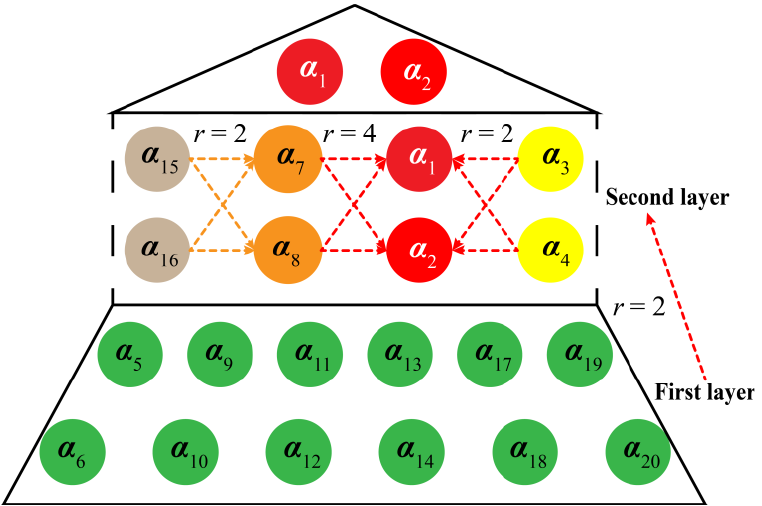
Figure 10. The polynomial functional relationship between active modal coefficients where r repre- sents the order of the library Θ(x). The α 1 and α 2 are active modal coefficients. sents the order of the library Θ (x). The α 1 and α 2 are active modal